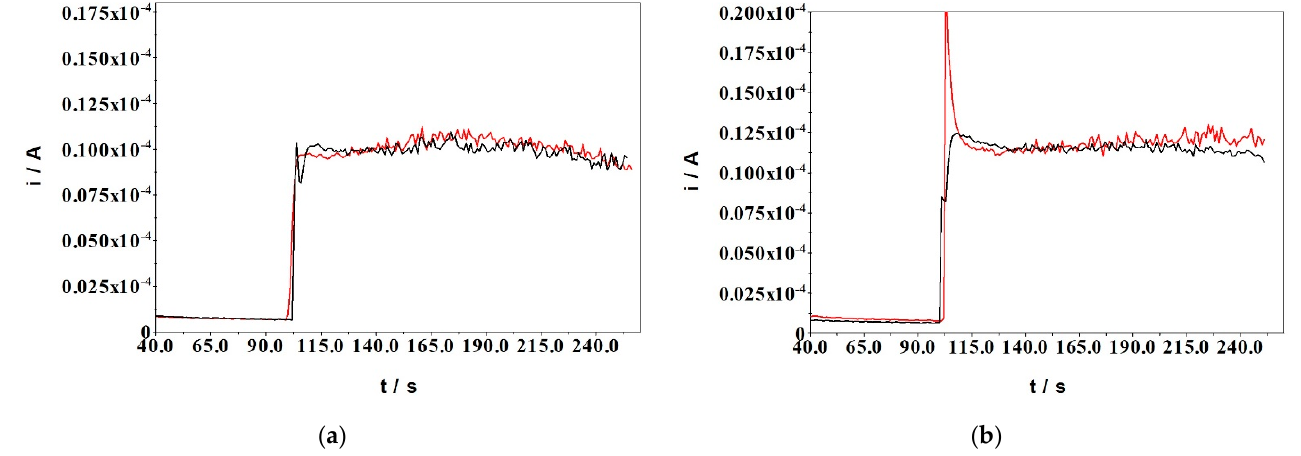
Figure 9. Amperometric response for 0.64 mM cholesterol injected in the reaction mixture (chloroform-TBAP + acetic anhydride + H 2 SO 4 ) (black line) and in the reaction mixture containing also: ( a ) 0.5 mM KCl and ( b ) 0.1 mM ascorbic acid (red line).